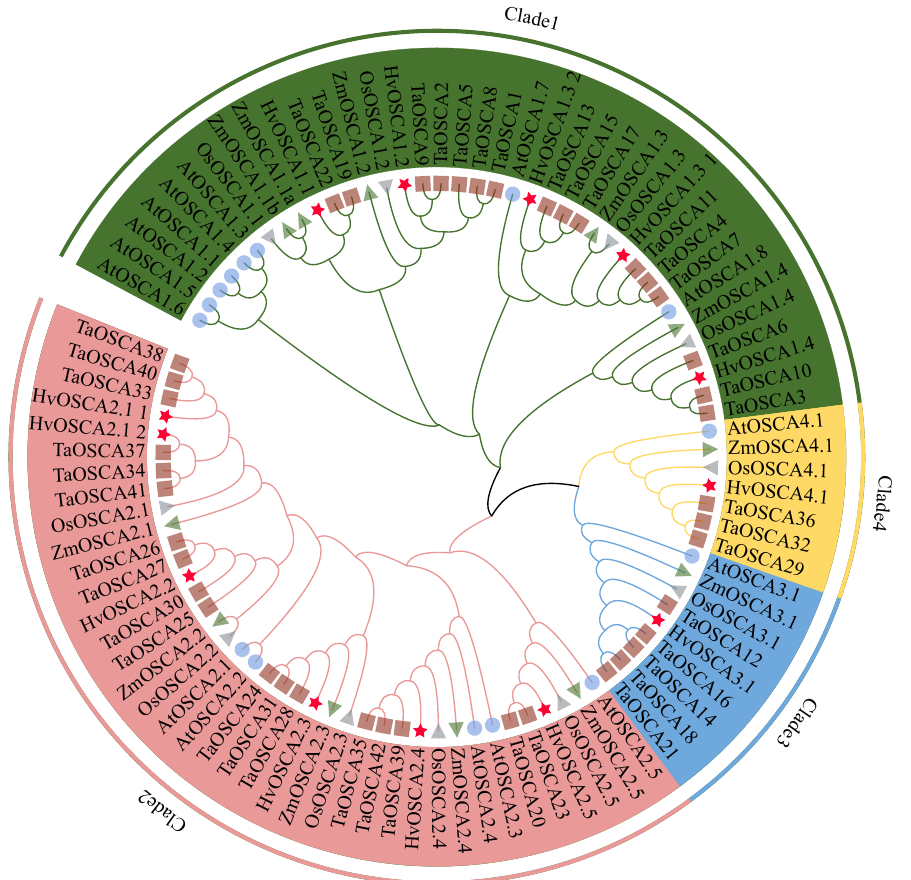
Figure 1. Phylogenetic analysis of the OSCA genes in Hordeum vulgare ( Hv ), Arabidopsis thaliana (At), Triticum aestivum (Ta), Oryza satival (Os) and Zea mays (Zm) by the neighbor-joining method. The OSCAs were clustered into four clades; each member of the OSCAs were annotated by ( (cid:70) for Hv ), ( • for At), ( (cid:4) for Ta), ( for Os) and ( for Zm), (cid:16) (cid:17)